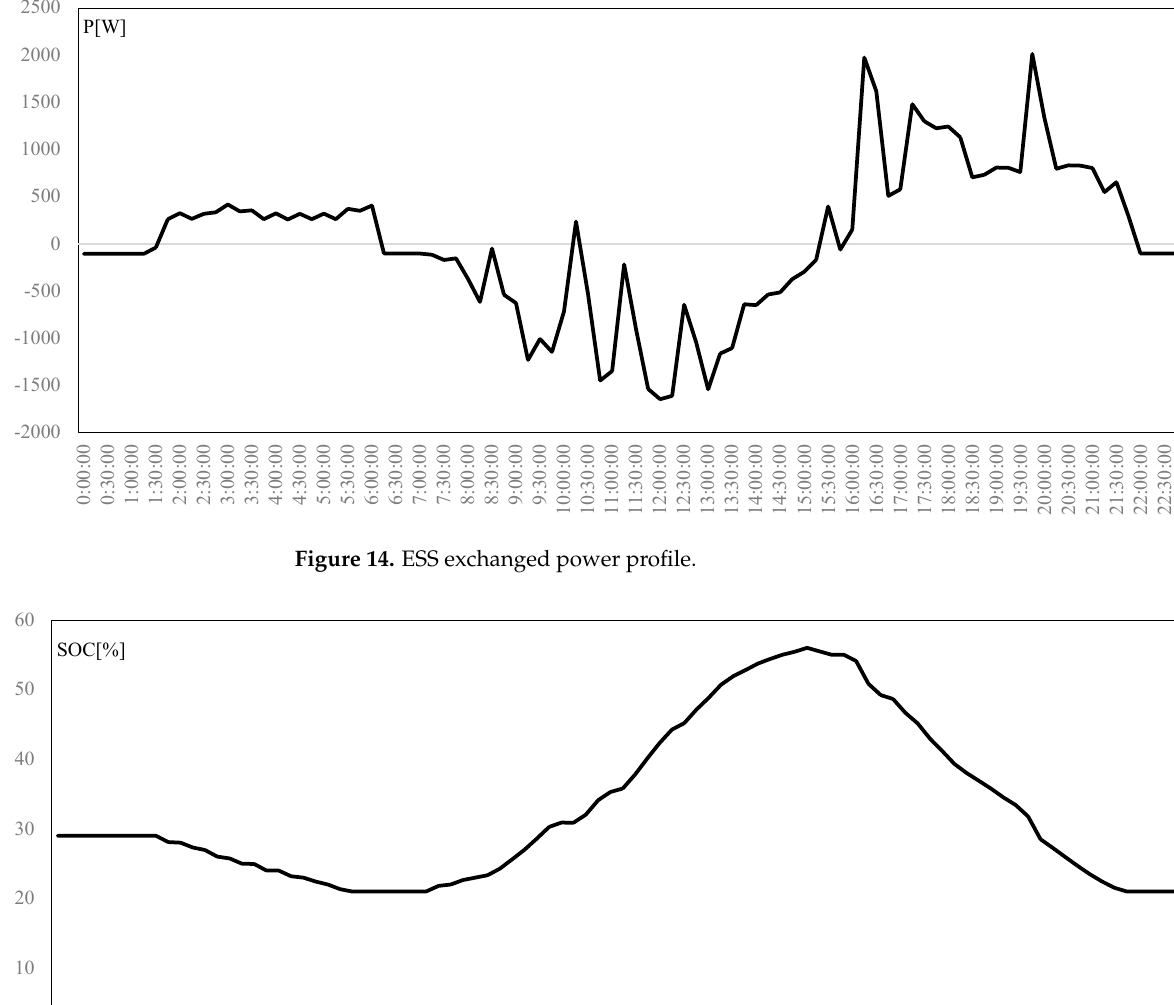
Figure 13. Exchanged grid net power.